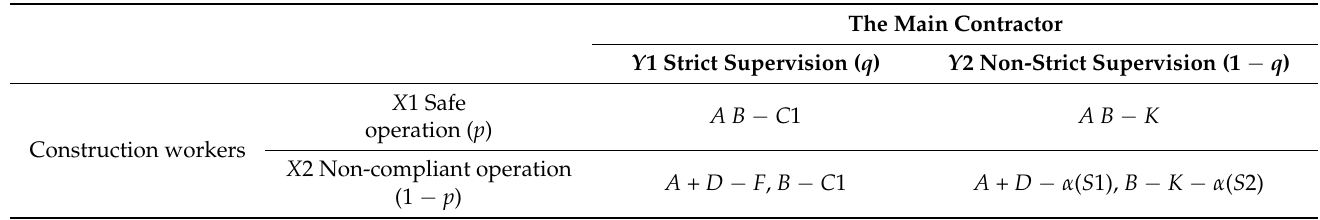
Table 2. Gain matrix of the game between the main contractor and construction workers. The Main